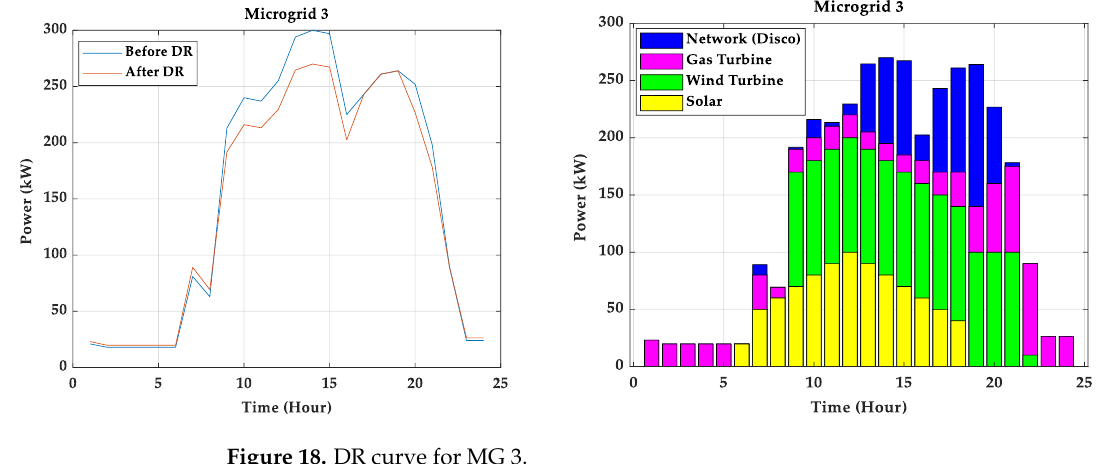
Figure 17. Impact of DR on MG 2.